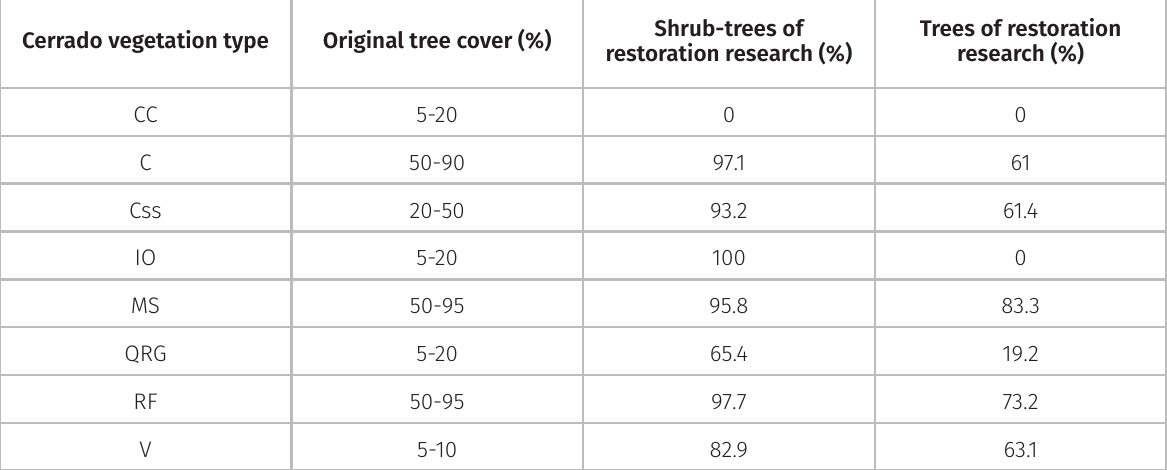
Table VI. The tree cover that characterize each of the Cerrado vegetation type and the proportion of trees and shrub-trees found in ecological restoration research (assisted regeneration approach). The trees of restoration research comprises all trees used in relation to the other growth forms while the shrub-trees of restoration research comprises all plant species with shrub, shrub-tree and tree growth forms used. The Cerrado vegetation types are CC ( campo cerrado ), C ( cerradão ), Css ( cerrado sensu stricto ), IO (ironstone outcrop), MS ( mata seca ), QRG (quartzitic rupestrian grassland), RF (riparian forest) and V ( vereda ). Shrub-trees of Trees of restoration Cerrado vegetation type Original tree cover (%) restoration research (%) research